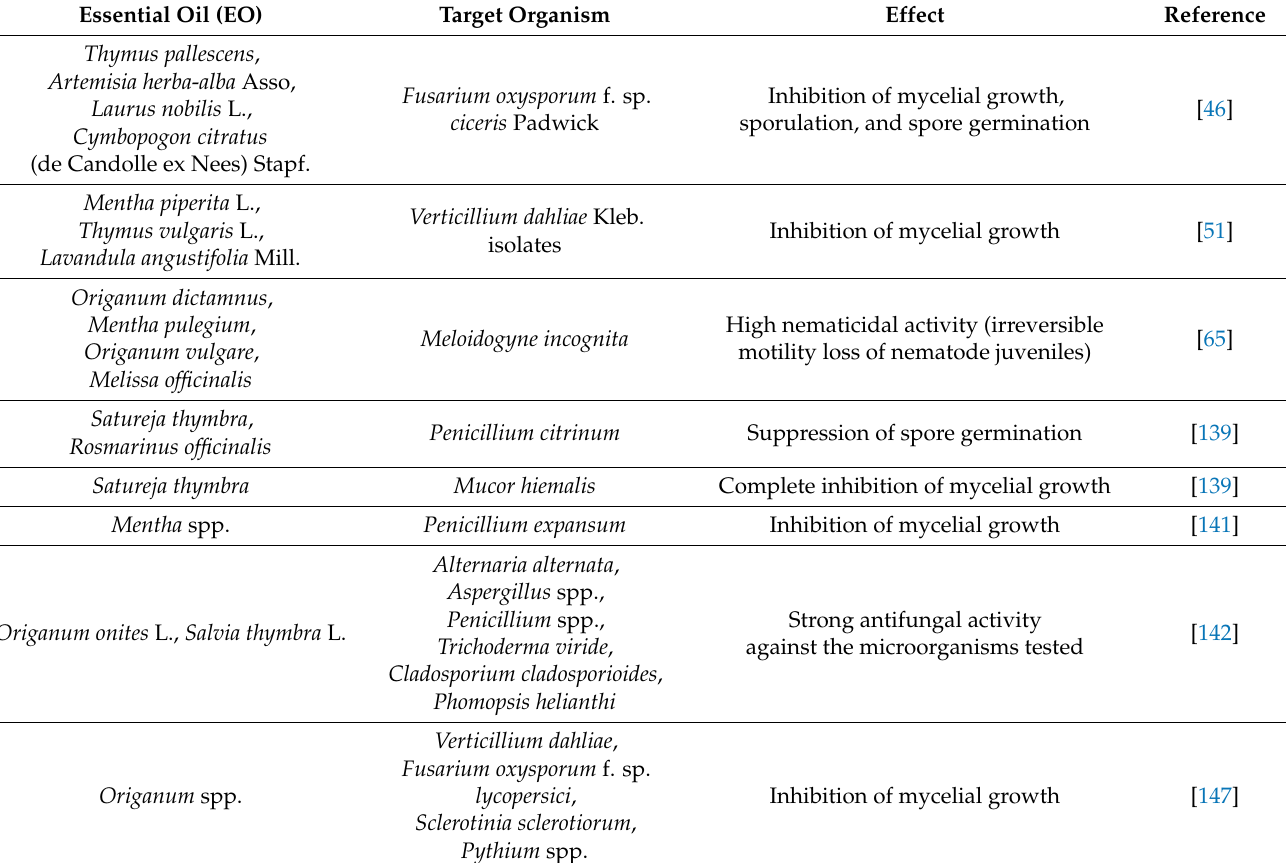
Table 1. Properties of essential oils and/or essential oil constituents, dealt with in this review paper, against soil-borne organisms and related